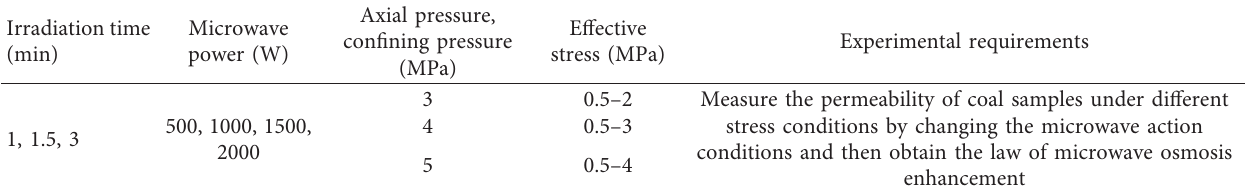
Table 2: Experimental permeability measurement